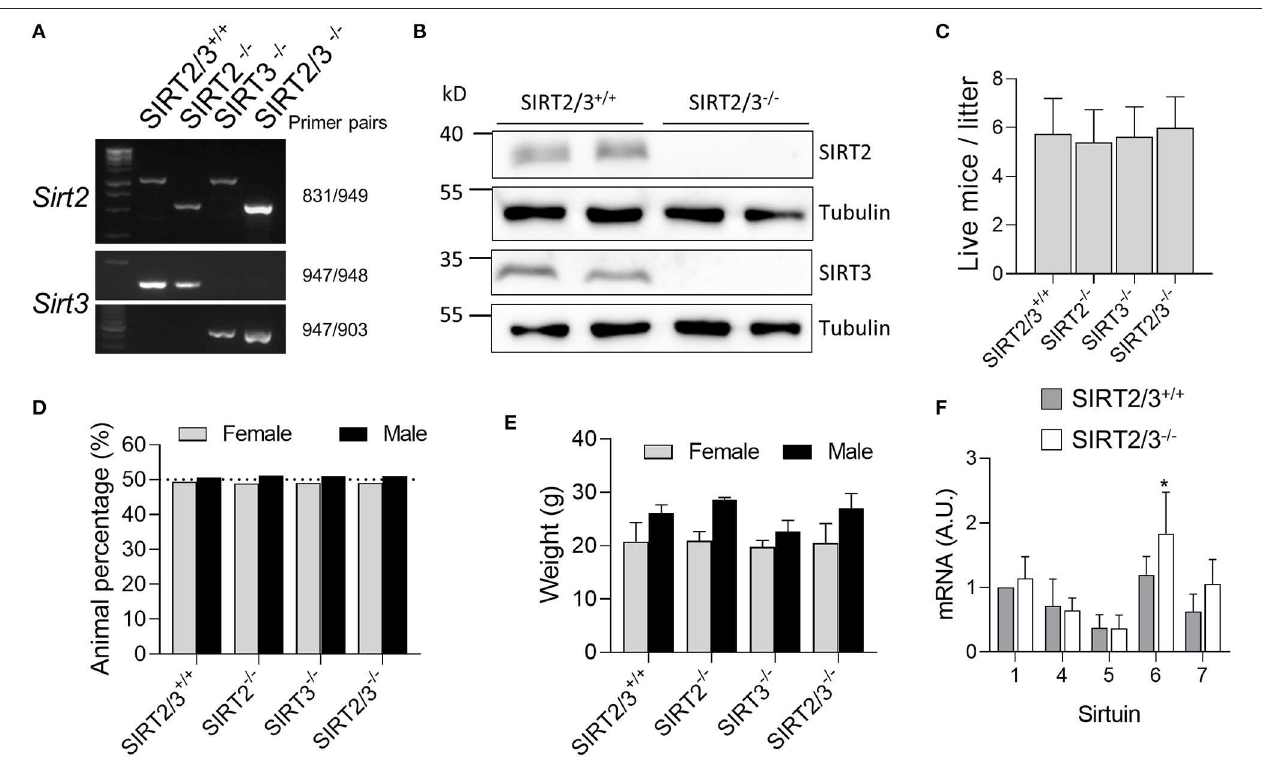
FIGURE 1 | Establishment of a SIRT2/3 − / − mouse line. (A) Genotyping of SIRT2/3 + / + , SIRT2 − / − , SIRT3 − / − , and SIRT2/3 − / − mice. Genomic DNA was amplified by PCR using the primer pairs specified on the right. Reaction mixtures were electrophoresed through agarose gels before imaging. (B) Western blot analysis of SIRT2, SIRT3 and tubulin expression in SIRT2/3 + / + and SIRT2/3 − / − BMDMs (Full blots are presented in Supplementary Figure 1 ). (C,D) Number of individuals (C) and female/male distribution (D) of SIRT2/3 + / + , SIRT2 − / − , SIRT3 − / − and SIRT2/3 − / − litters. (E) Weight of SIRT2/3 + / + , SIRT2 − / − , SIRT3 − / − , and SIRT2/3 − / − adult female and male mice. (F) mRNA expression of SIRT1 and SIRT4-7 in SIRT2/3 − / − BMDMs were quantified by RT-qPCR and normalized to actin mRNA. Data are mean ± SD of eight mice analyzed in triplicate. * P < 0.05.